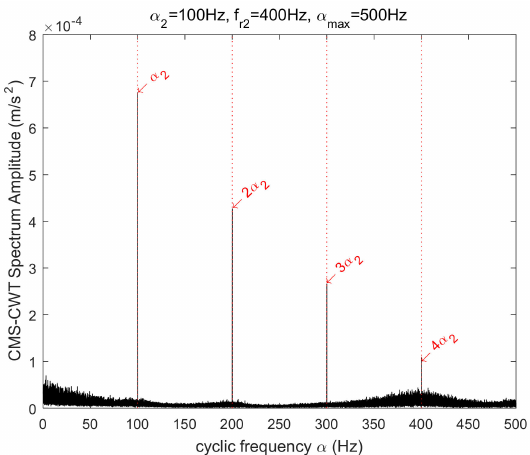
Figure 3. Vibration spectrum analysed by fast spectral correlation (FSC) with R = 32.